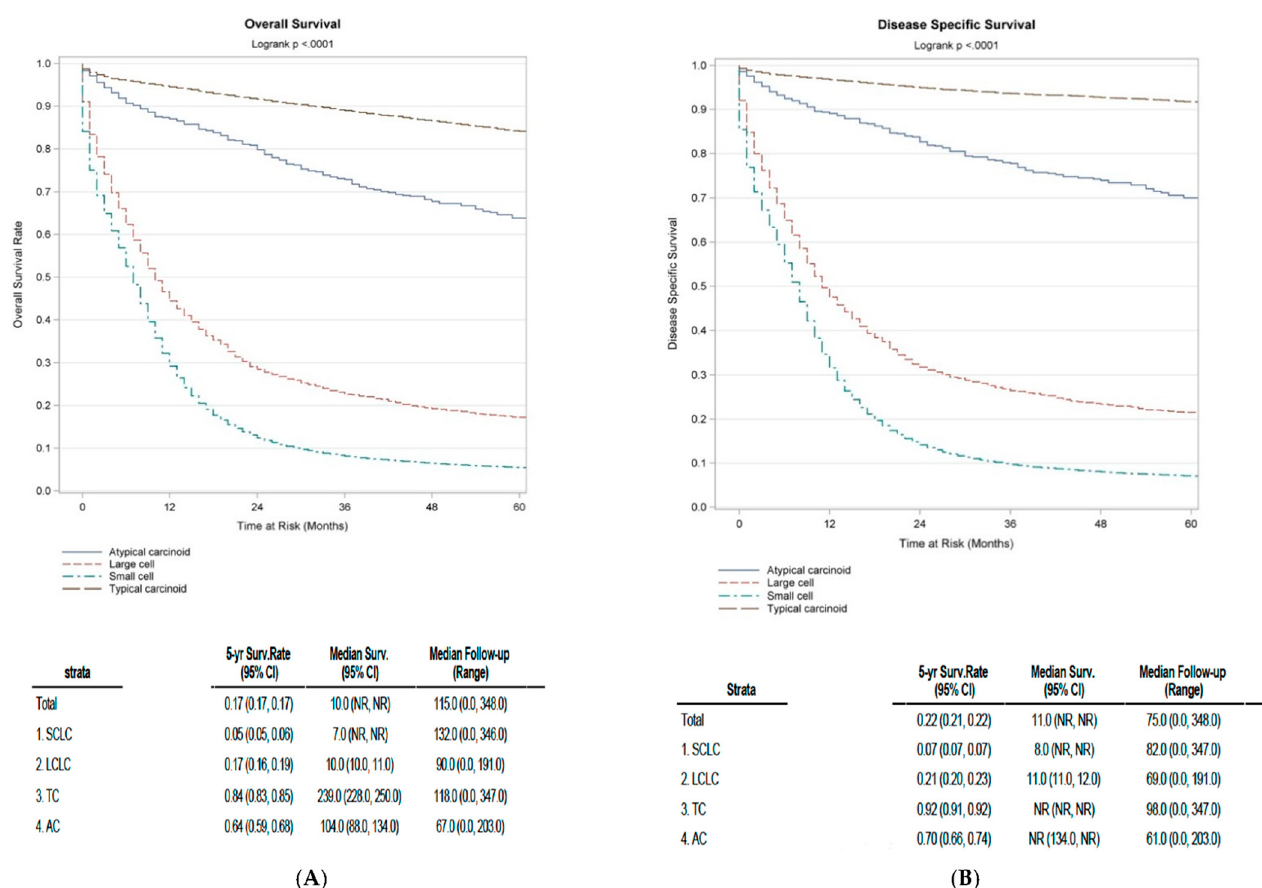
Figure 2. ( A ) Unadjusted Kaplan-Meier curves depicting median overall survival (OS) of lung cancer patients based on different histological type. ( B ) Unadjusted Kaplan-Meier curves depicting median disease-specific survival (DSS) of lung cancer patients based on different histological type.